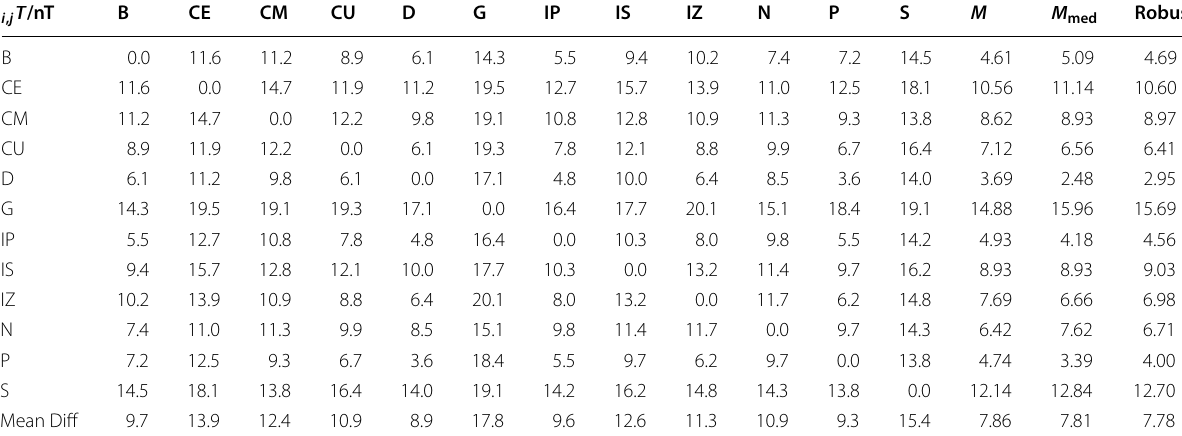
The bottom row is the simple arithmetic mean of the columns